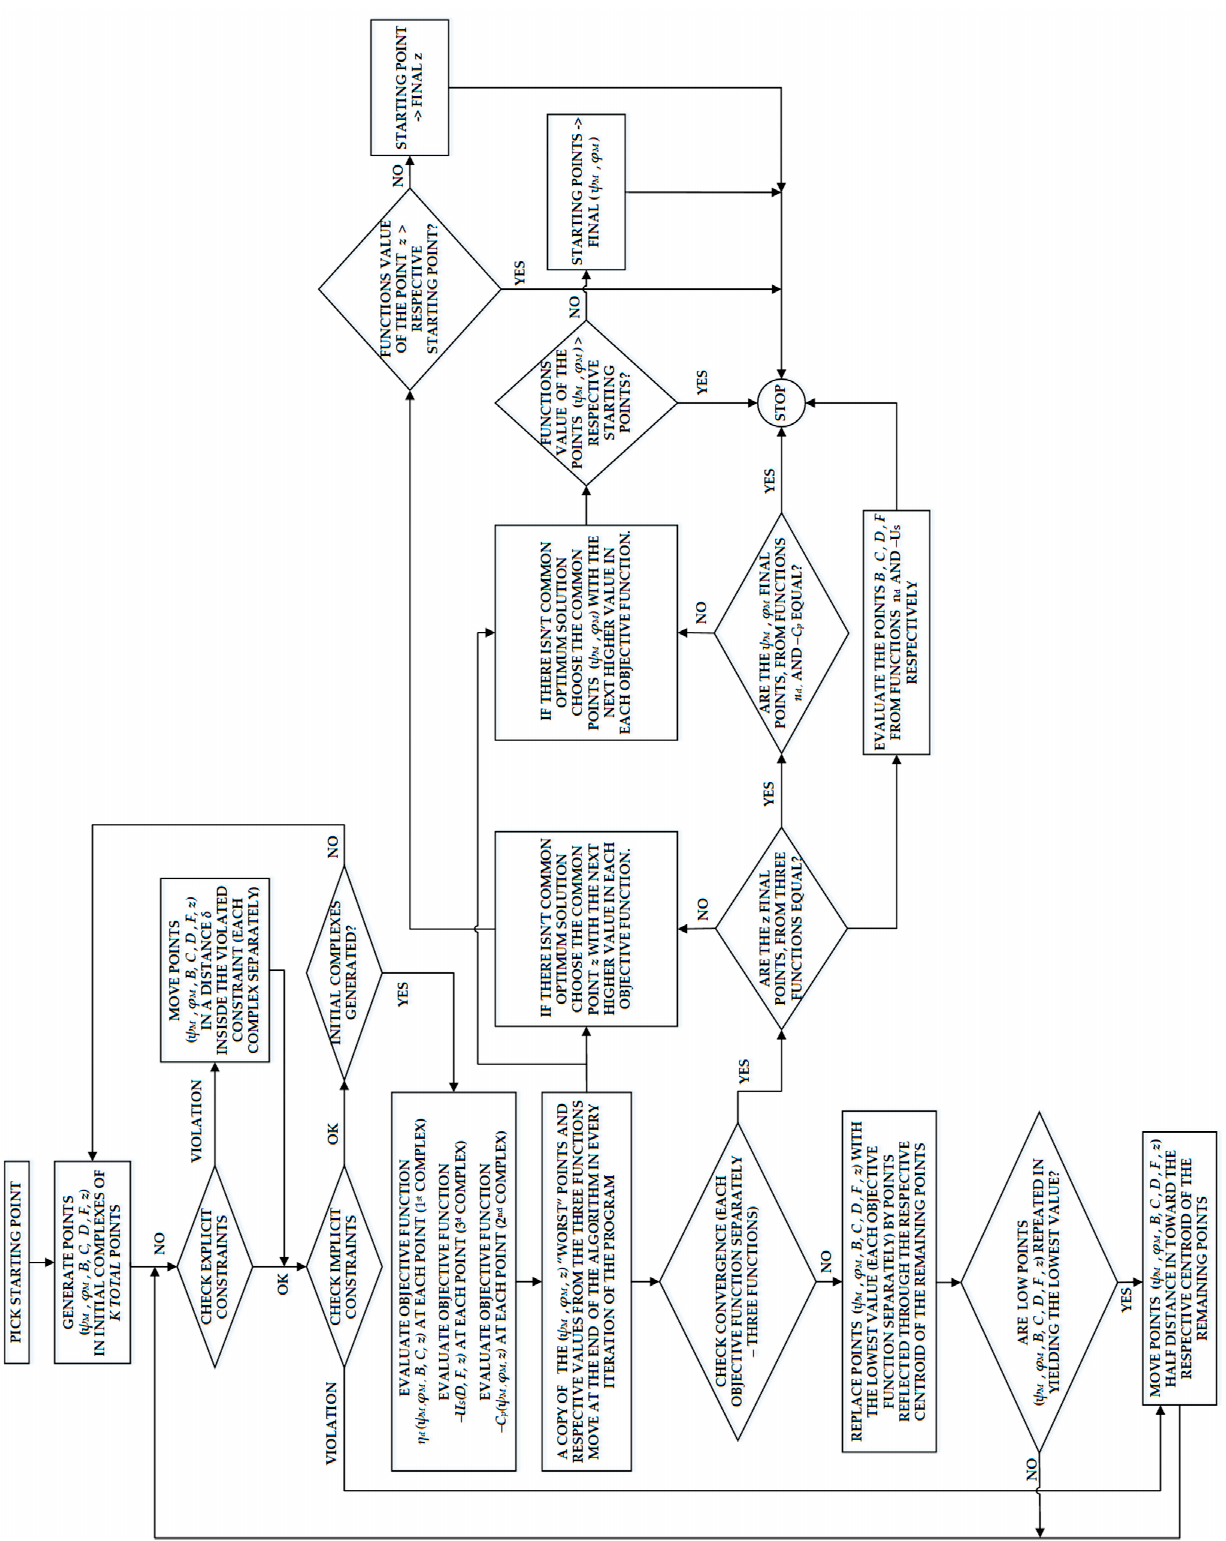
Figure 5. Analytical presentation of the multi-criteria design analysis methodology (flow chart that is included in the central image of Figure 4). included in the central image of Figure